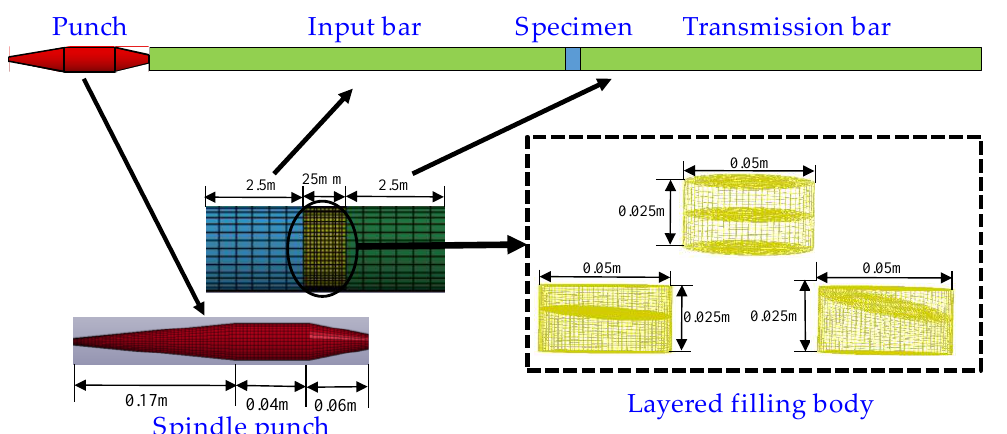
Figure 15. Establishment of a finite element model for a layered filling body.